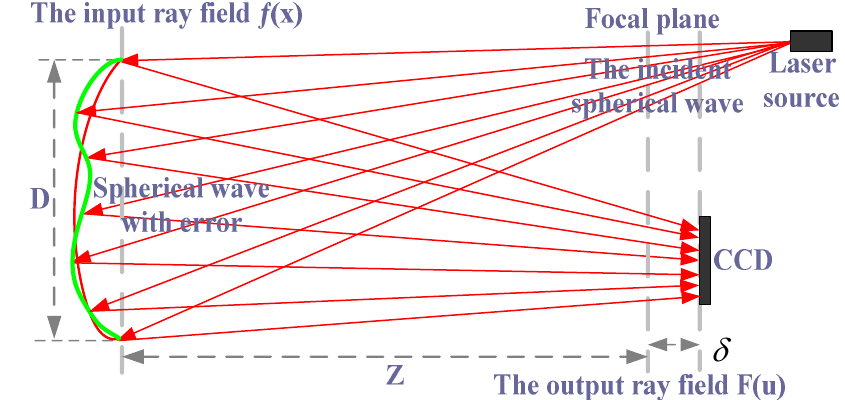
Figure 1. The principle of the PR system [26].